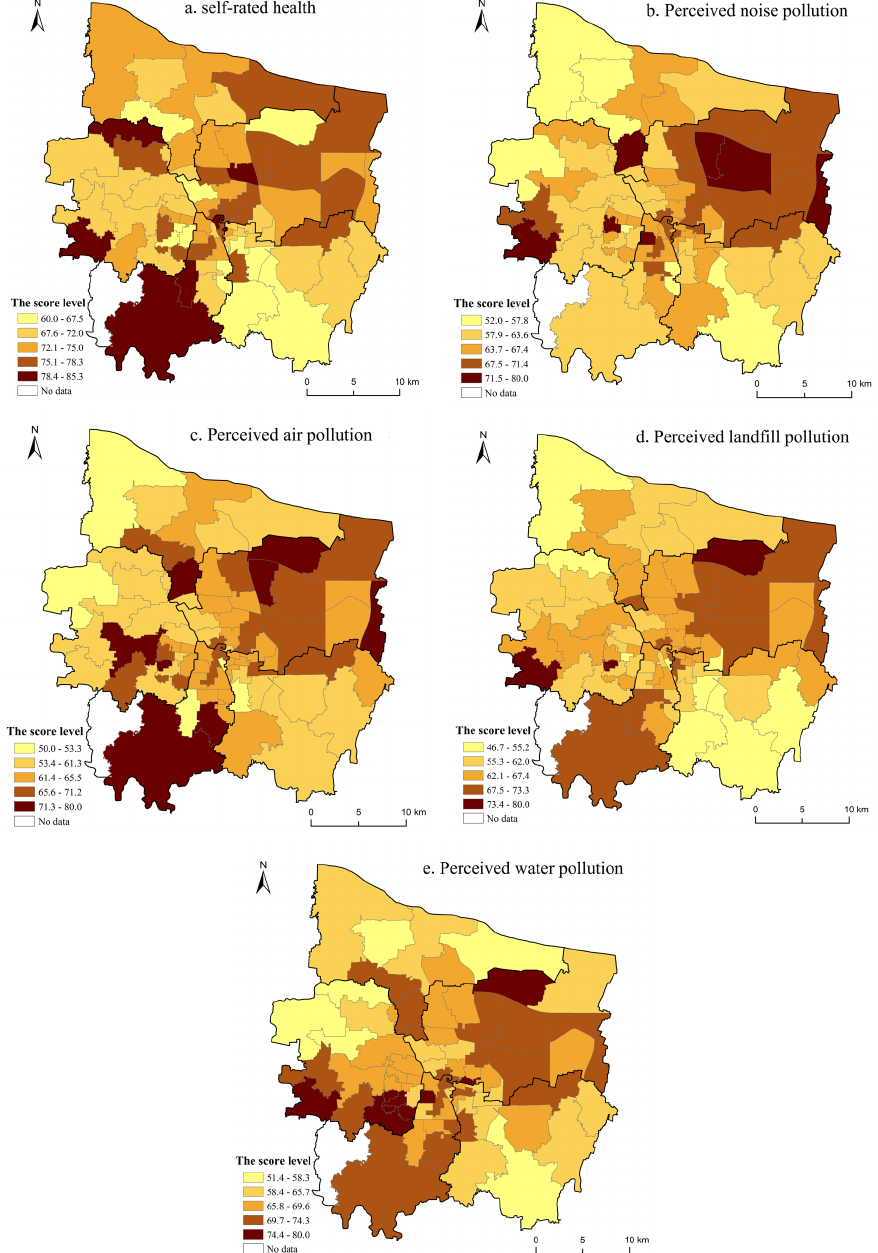
Figure 5. Spatial pattern of self-rated health ( a ) and four perceived environmental hazards ( b – e ) at the subdistrict (jiedao) level of Zhengzhou City.